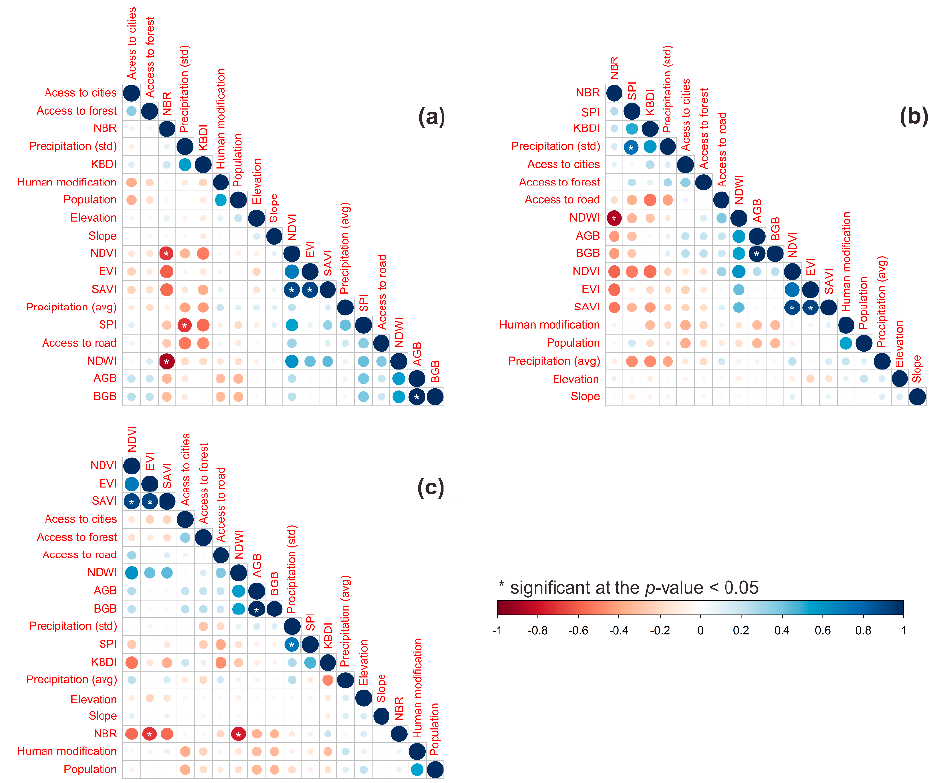
Figure 2. Degree of collinearity for the model under ( a ) El-Nino, ( b ) Normal, and ( c ) La-Nina phase using variables selection (| r | ≤ 0.7). Significant pairwise variables indicate a strong multicollinearity between pair of variables, thus we considered to eliminate one of them.